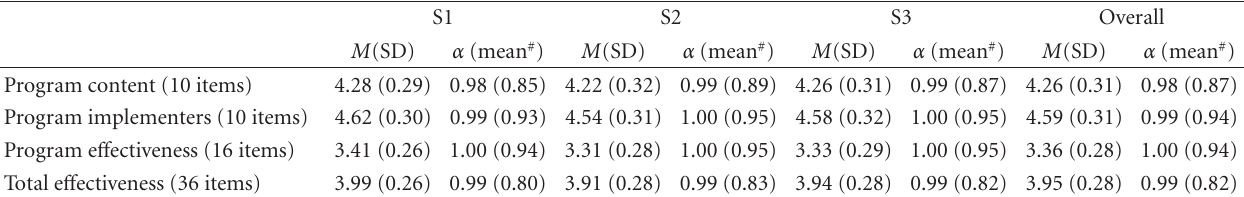
Table 6: Means, standard deviations, Cronbach’s alphas, and mean of interitem correlations among the variables by grade. S1 S2 S3 Overall